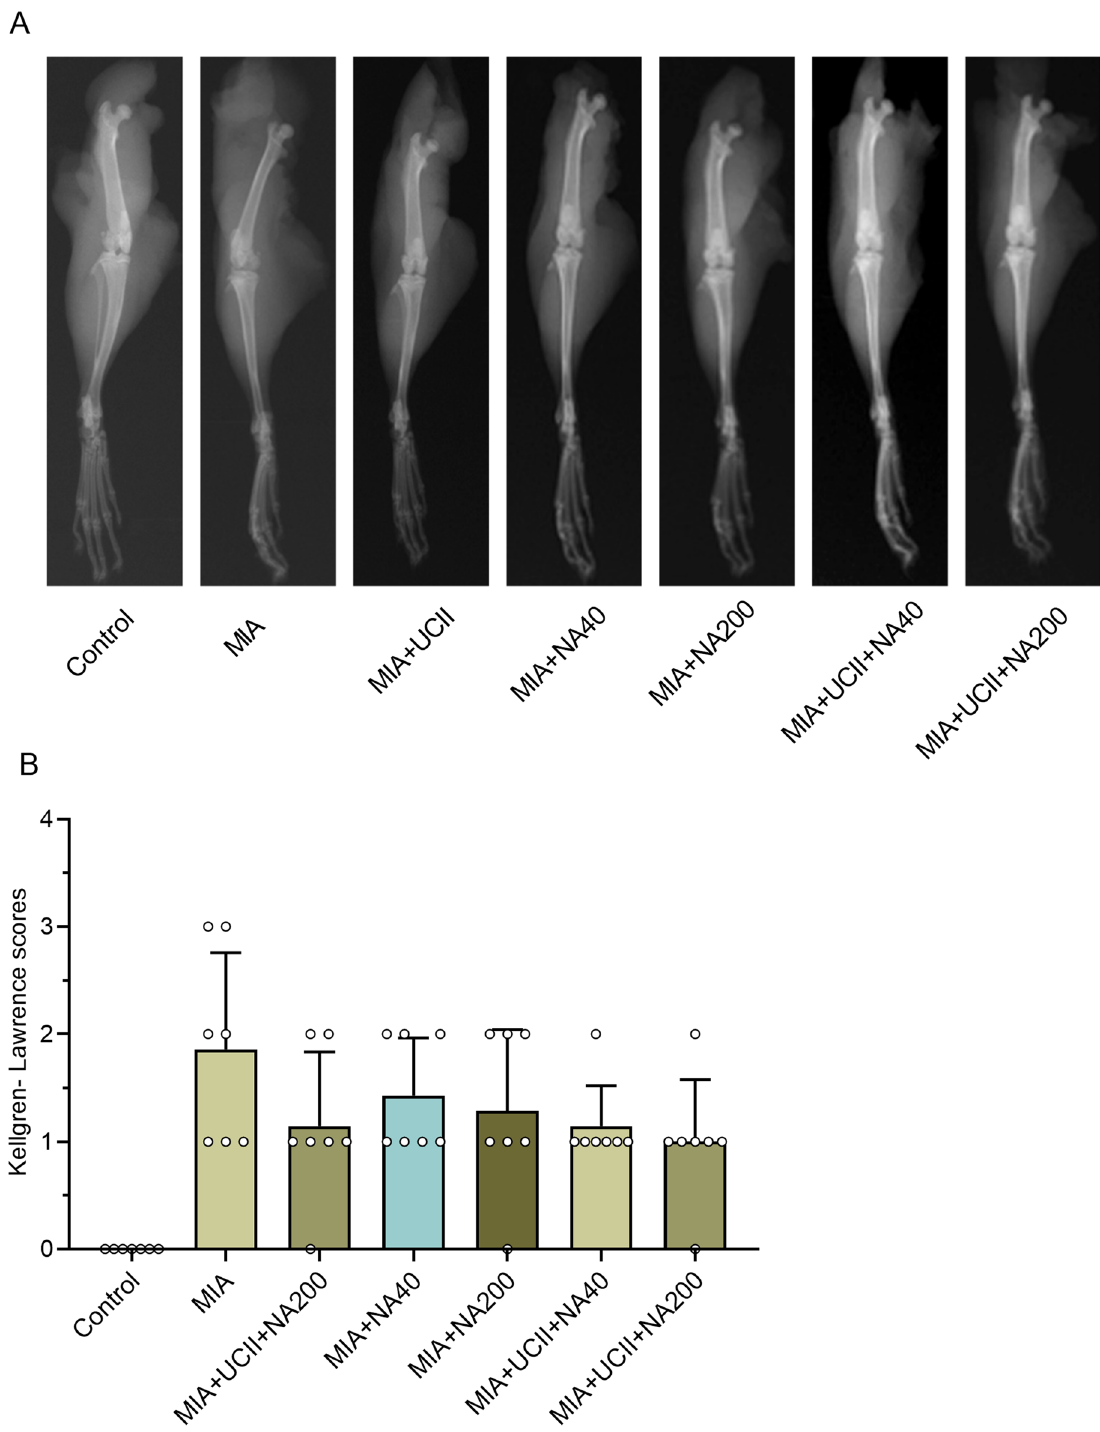
Figure 3. Effects of niacinamide (NA) and undenatured type II collagen (UCII) supplementation on knee joint in monosodium iodoacetate (MIA)-induced osteoarthritis in rats (n = 7). Representative radiographic images (A) obtained at the end of the experiment are shown. Mean values of Kellgren- Lawrence scores are demonstrated (B) with ± standard deviations (Kruskal–Wallis followed by Mann–Whitney U; p > 0.05). Control as a non-supplemental group with no osteoarthritis-induced rats, MIA as a non-supplemental group with monosodium iodoacetate (MIA)-induced knee osteoarthritis, MIA + UCII as MIA group gavage-fed a supplemental UCII at 4 mg/kg, MIA + NA40 as MIA group gavage-fed supplemental niacinamide (NA) at 40 mg/kg, MIA + NA200 as MIA group gavage-fed a supplemental NA at 200 mg/kg, MIA + UCII + NA40 as MIA group gavage-fed both supplemental UCII at 4 mg/kg and NA at 40 mg/kg and MIA + UCII + NA200 as MIA group gavage-fed both supplemental UCII at 4 mg/kg and NA at 200 mg/kg. Oral gavage delivery of supplements was applied from d7 to